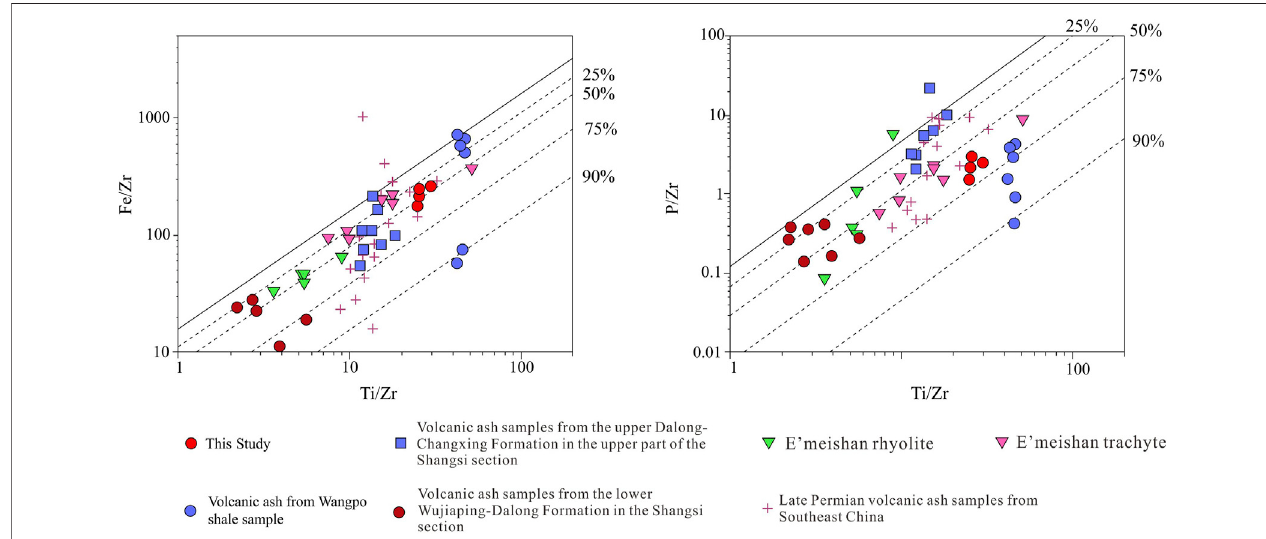
FIGURE 9 | Nutritive element loss based on intrusive rock data from south China [after Zhao et al. (2020)]. Black lines indicate plutonite data from the South China plate; four dotted lines indicate the loss of 25, 50, 75%, and 90, respectively. Wangpo-shale volcanic ash data was taken from Huang et al. (2016); the data for the volcanic ash from the Wujiaping-Changxing Formations in the Shangsi section was taken from Huang et al. (2018); the data of rhyolites and trachytes from the Emei Mountain were taken from Xu et al. (2010); the data from the last-phase volcanic ash of the Upper Permian Series in southeast China, was taken from (Liao et al., 2016a; Liao et al., 2016b); and post-Archean Australian shale data was taken from McLennan (2018).